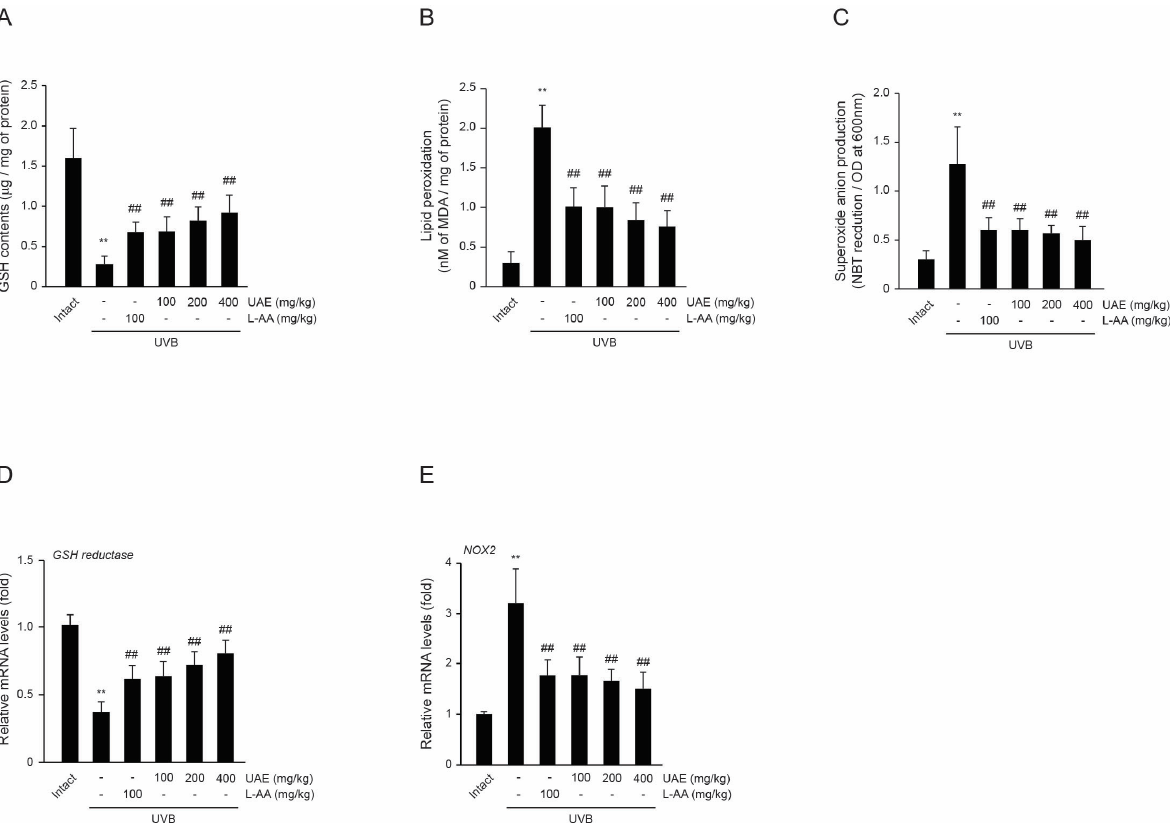
Figure 4. Effects of UAE on UVB-induced oxidative stress. ( A ) GSH contents, ( B ) malondialdehyde (MDA), and ( C ) superoxide anion production was measured in the skin tissues. Data were normalized by total proteins in the skin tissue. ( D ) GSH reductase ( E ) NOX2 mRNA expression levels in dorsal back skin tissue were quantified by real-time PCR. Data are expressed relative to intact/b-actin. Results are presented as mean ± SD (n = 10, significant difference vs. intact control; ** p < 0.01, vs. UVB-irradiated control mice; ## p < 0.01).